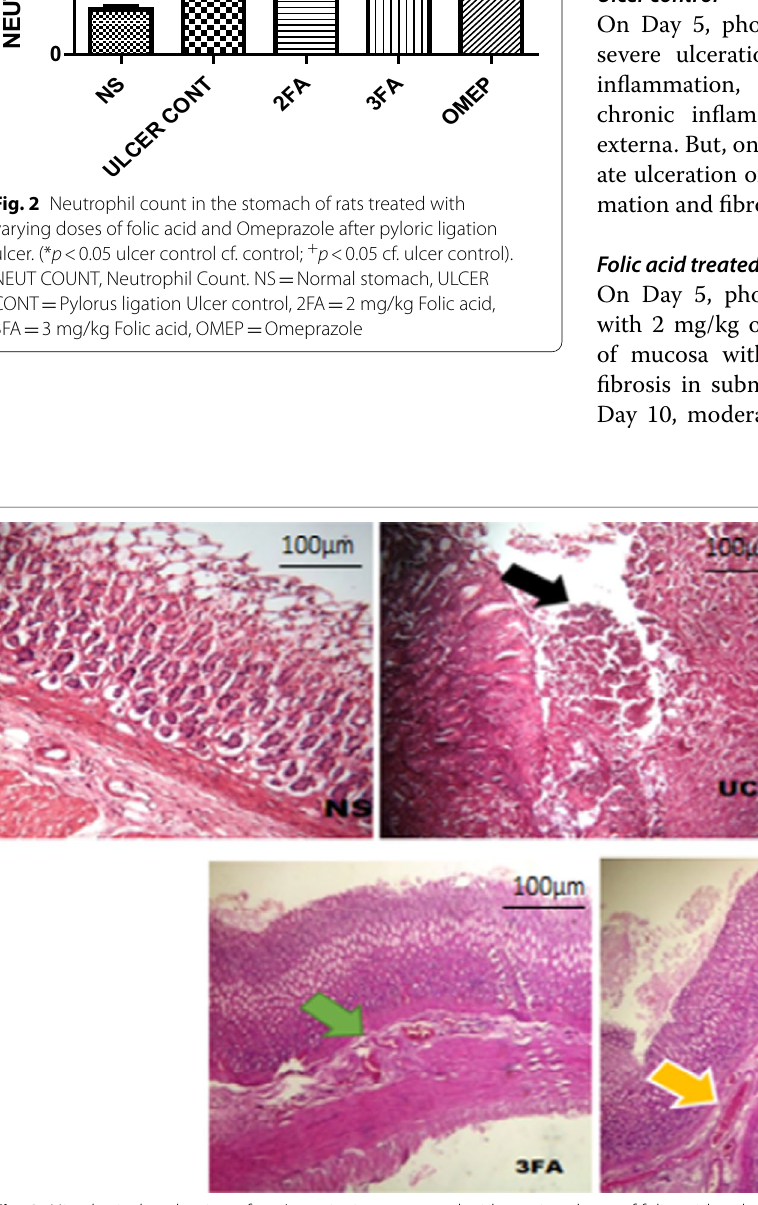
Fig. 3 Histological evaluation of rats’ gastric tissues treated with varying doses of folic acid and omeprazole prior pyloric ligation, (H&E, X40). NS (overall control) Normal mucosa and submucosa. UC (Ulcer control) Acute inflammation of the mucosa as well as submucosa, with an = = appearance of cellular debris. 2FA Mild papillary infolding, mild inflammation of mucosa and submucosa . 3FA Moderate congestion of the = = mucosa and submucosa (green arrow), moderate inflammation of submucosa and mild erosion of the surface epithelial. OMEP Mild congestion = (orange arrow), mild infiltration of inflammatory cells and adipocytes into the